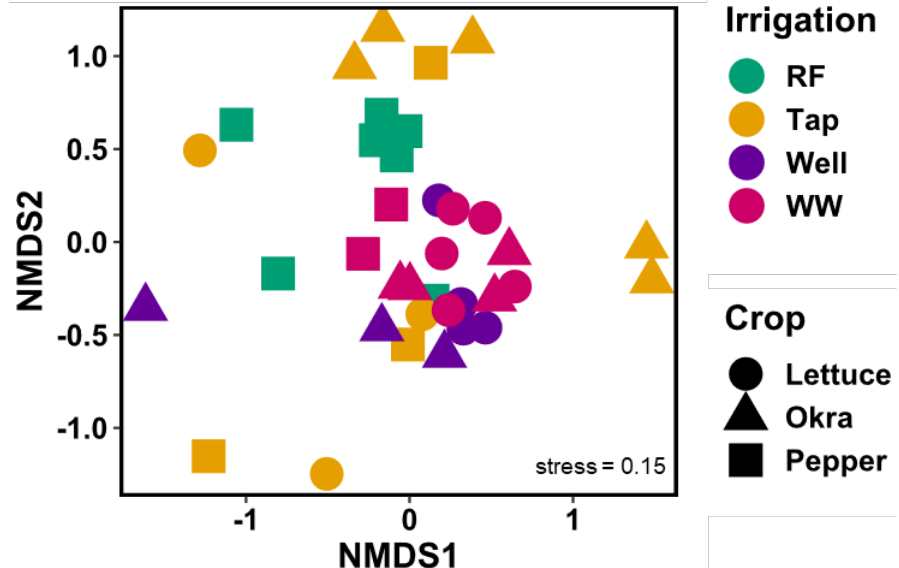
Figure 4. Non-metric multidimensional scaling (NMDS) biplot based on Bray–Curtis dissimilarity of all 36 arthropod communities caught on vegetable fields considering irrigation source, namely, rainfed (RF; green), tap water (Tap; yellow), well water (Well; purple), wastewater (WW; magenta) and crop type by using the 24 most abundant and equally distributed species sampled in UPA systems in Tamale, Northern Region, Ghana in August 2016 .